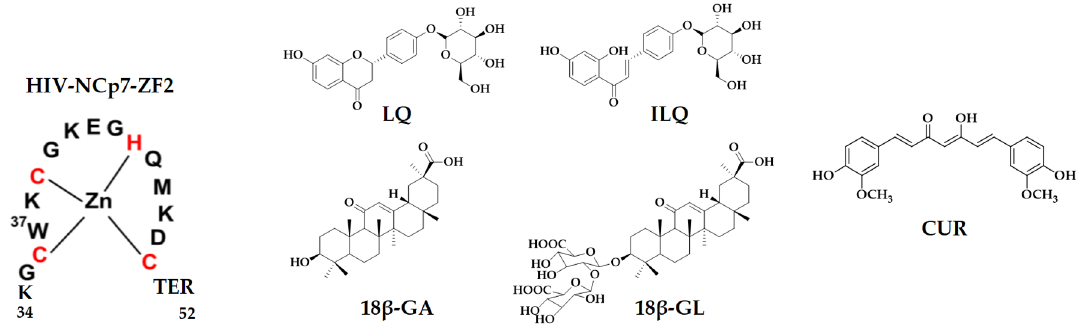
Figure 1. Sequence of the C ‐ terminal zinc finger of HIV ‐ NCp7 and the chemical structures of the compounds used in this study.